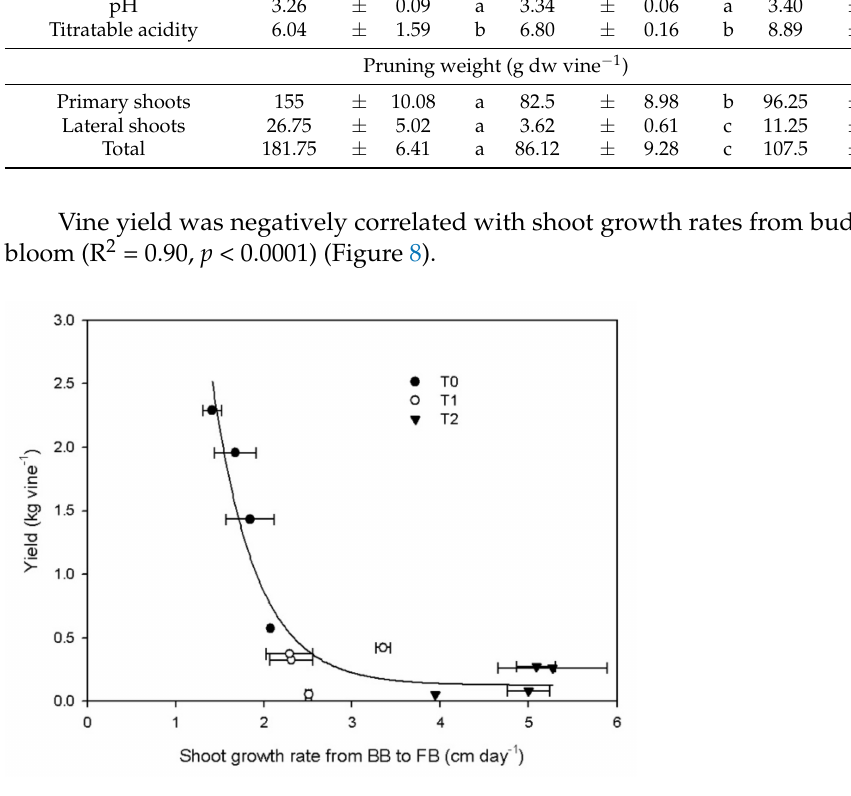
Figure 8. Vine yield vs. shoot growth rate from budburst (BB) to full bloom (FB) in T0, T1, and T2 vines ( n = 4). Mean ± SE ( Yield = 0.13 + 41.26 × exp( − 2.01 × shoot growth rate), R 2 = 0.90, p < 0.0001). The correlation was linear up to a shoot growth rate of about 2.5 cm day − 1 ; at higher shoot growth rates, there was no further significant reduction in yield. Mean number of inflorescences primordia in winter buds carried on the five basal nodes of the canes was 1.58 ± 0.14 in T0, 0.91 ± 0.15 in T1, and 0.58 ± 0.23 in T2. It was negatively correlated with mean shoot growth rate during the formation of the first five nodes (R 2 = 0.76, p < 0.0001) (Figure